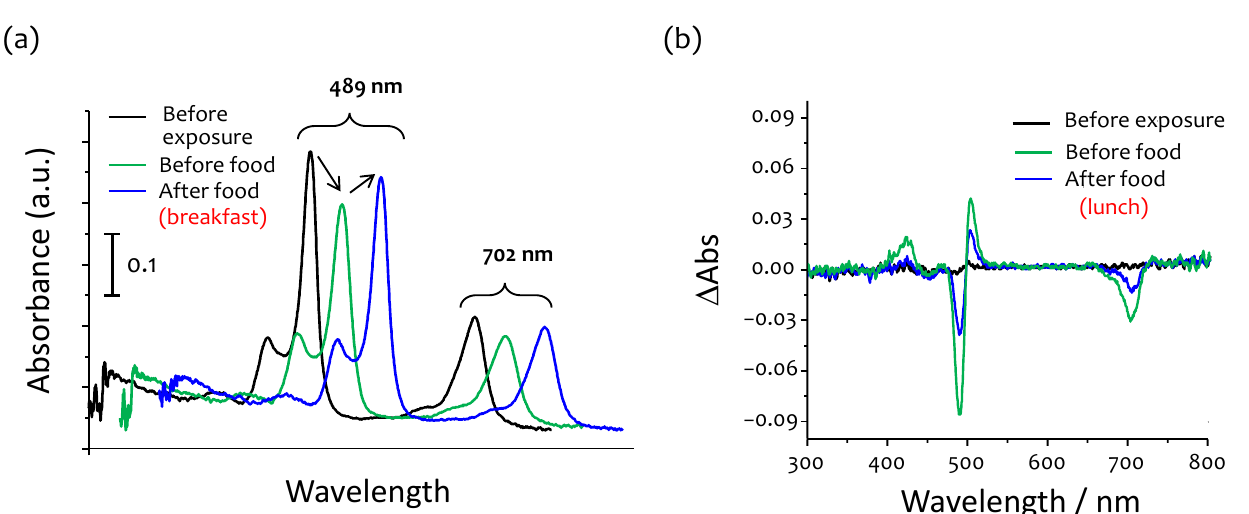
Figure 7. ( a ) UV–vis and ( b ) difference absorption spectra of the PDDA/TSPP film measured before (after HCl vapor treatment) and after food consumption in cases of breakfast and lunch, respectively. The spectra in Figure 7a are shifted horizontally for illustration purposes and convenience in reading the figure.